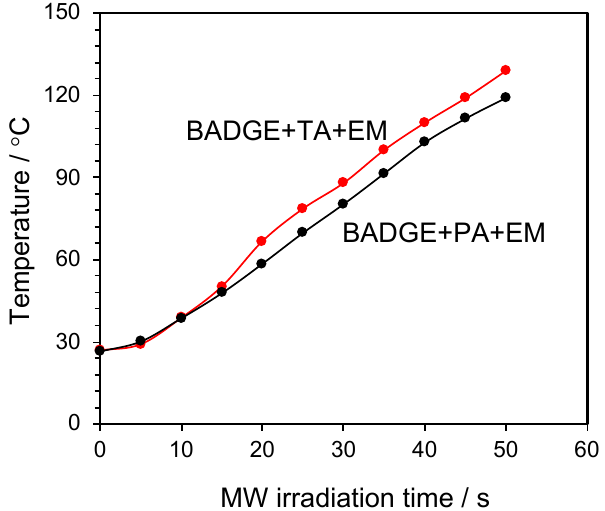
Figure 6. Temperature changes of naked (BADGE + TA + EM) versus (BADGE + PA + EM) adhesives under microwave irradiation by the electric field ( E -field; 10 W) from a single-mode applicator and a semiconductor microwave generator.